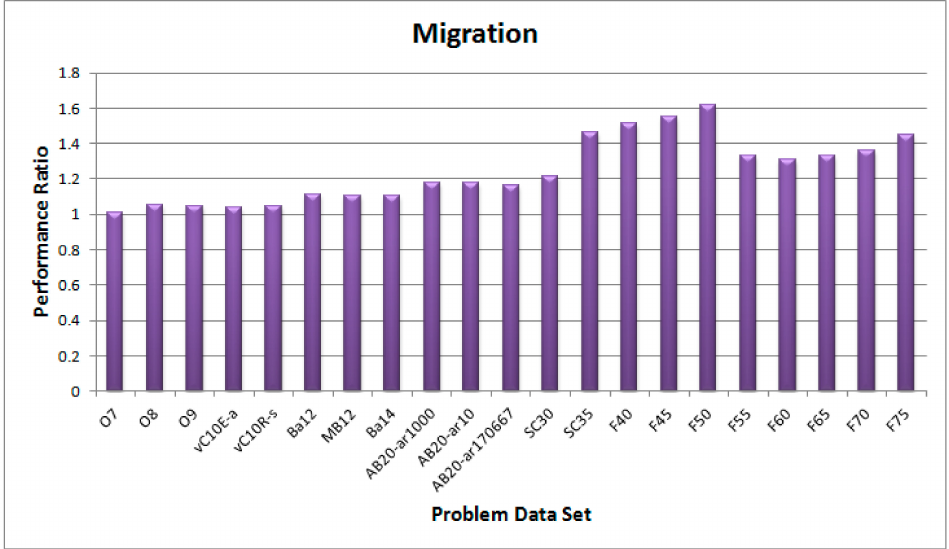
Figure 13. Performance ratio between MIG_G and MIG_I for